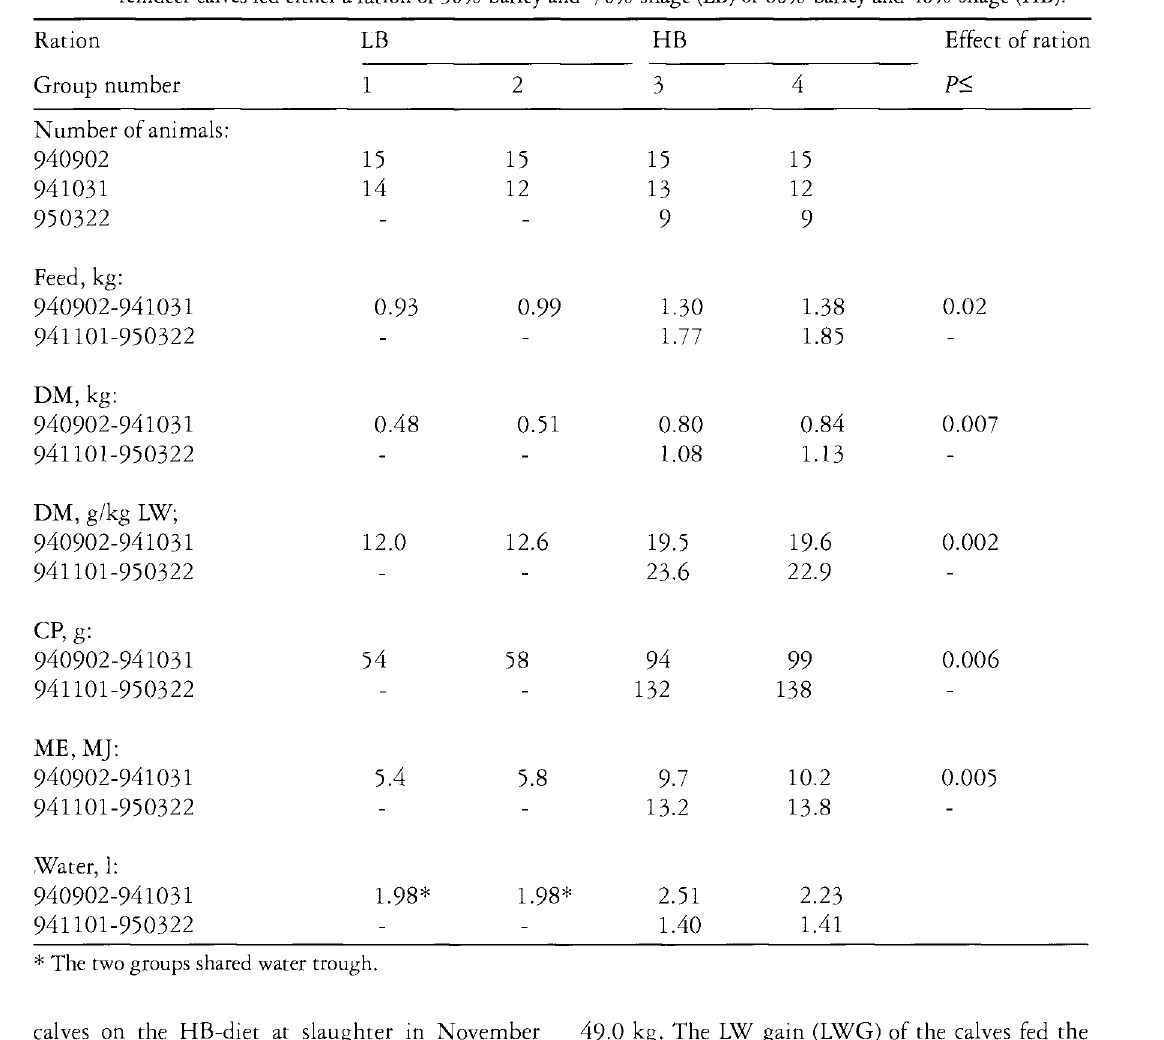
Table 2. Number of animals and mean daily intakes per animal of feed, dry matter (DM), crude protein (CP), metaboli- sable energy (ME) and drinking water and daily dry matter (DM) intake per kg live weight (LW) in groups of reindeer calves fed either a ration of 30% barley and 70% silage (LB) or 60% barley and 40% silage